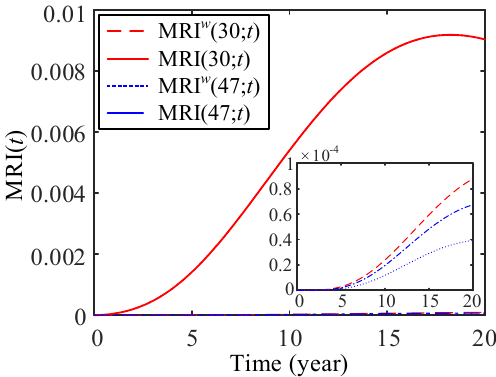
Figure 15. MRI of components (30 and 47) with and without